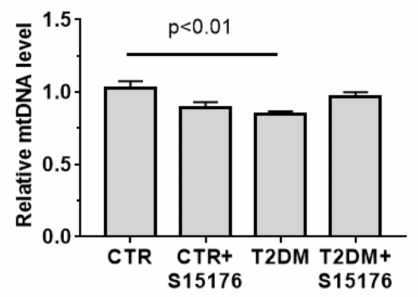
Figure 4. The relative mtDNA levels in the liver of experimental animals. A real-time qPCR was carried out to determine the mtDNA copy number, which is calculated as the ratio of mitochondrial DNA ( ND4 ) to nuclear DNA ( GADPH ) ( n = 5–6). The di ff erences were considered statistically significant at p <